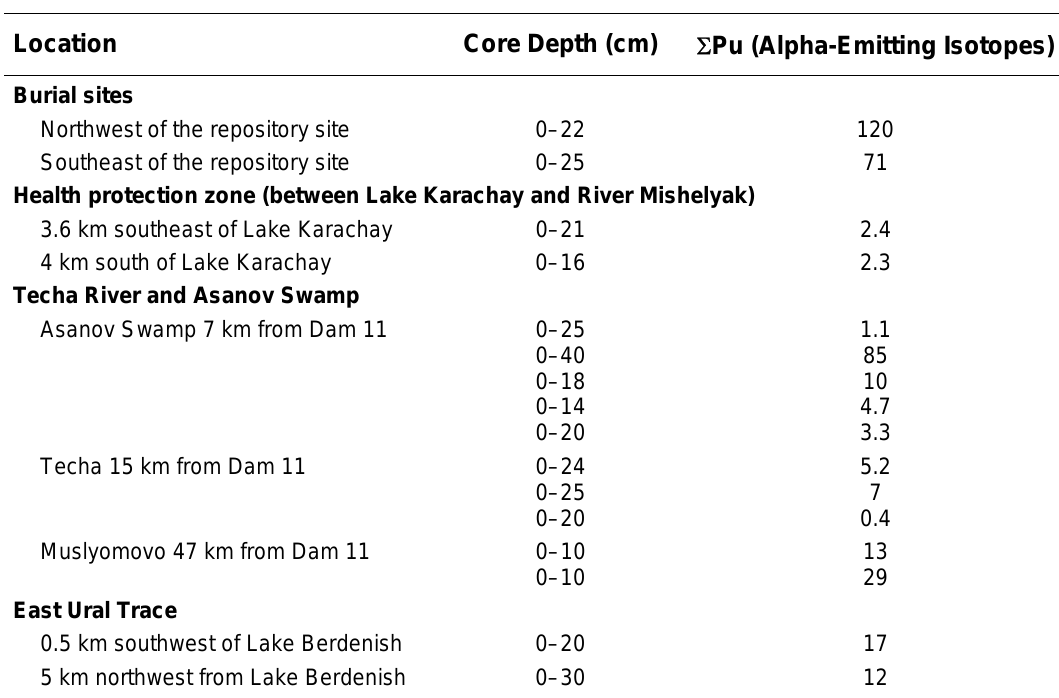
Mean Contamination Levels (kBq/m 2 ) in Surface Soils from the Mayak Area[29]